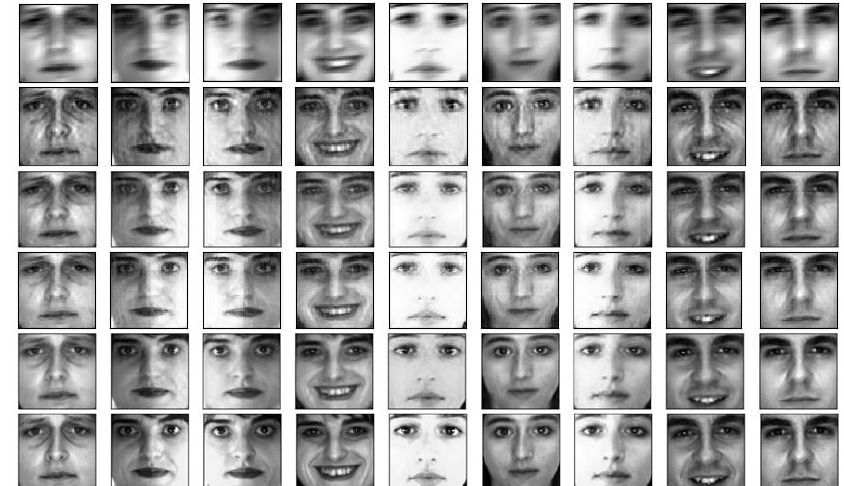
Figure 3. Restored images of human face. The first row shows the images with motion blur; the images from the second row to the fifth row are restored images of DnCNN, ResNet, ResNet with dilated convolution and FbResNet; the last row shows the clean images.